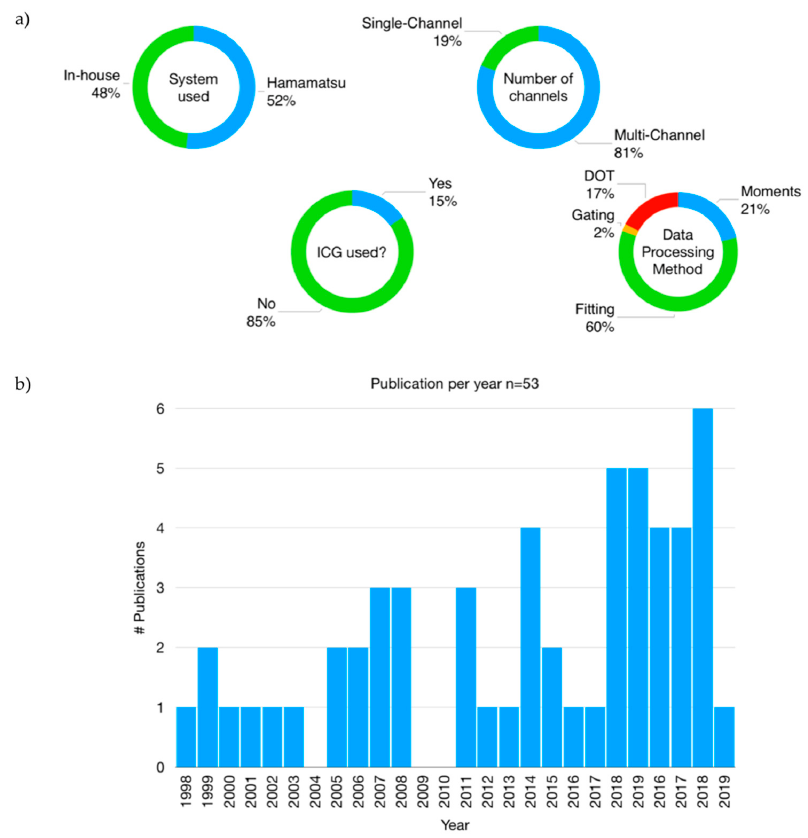
Figure 4. Summary of the literature review results. ( a ) Summary of the principle TD-NIRS component used in the 52 reviewed publications. ( b ) Graph showing the number of publications using TD-NIRS in brain clinical application since the first study in 1998.